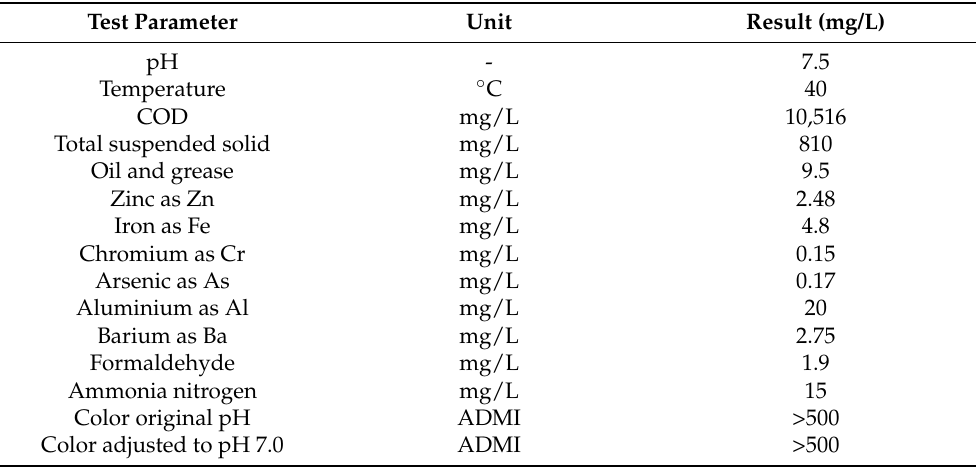
Table 1. Characteristics of the leachate sample collected from Jeram Landfill.